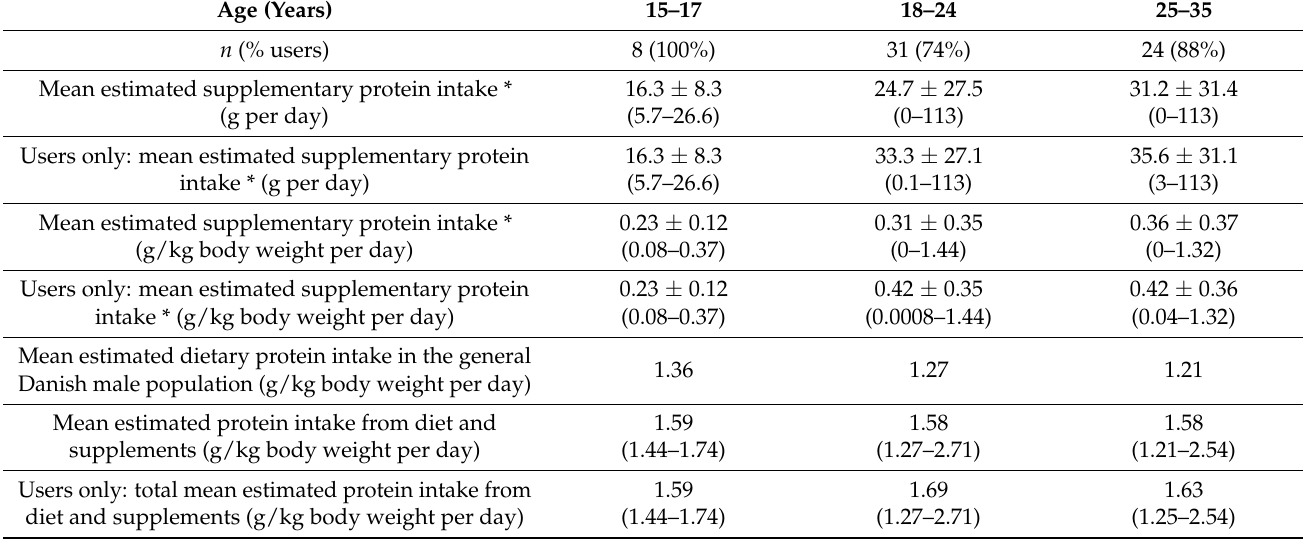
Table 3. Estimated mean protein intake from protein products in 15–35-year-old men attending